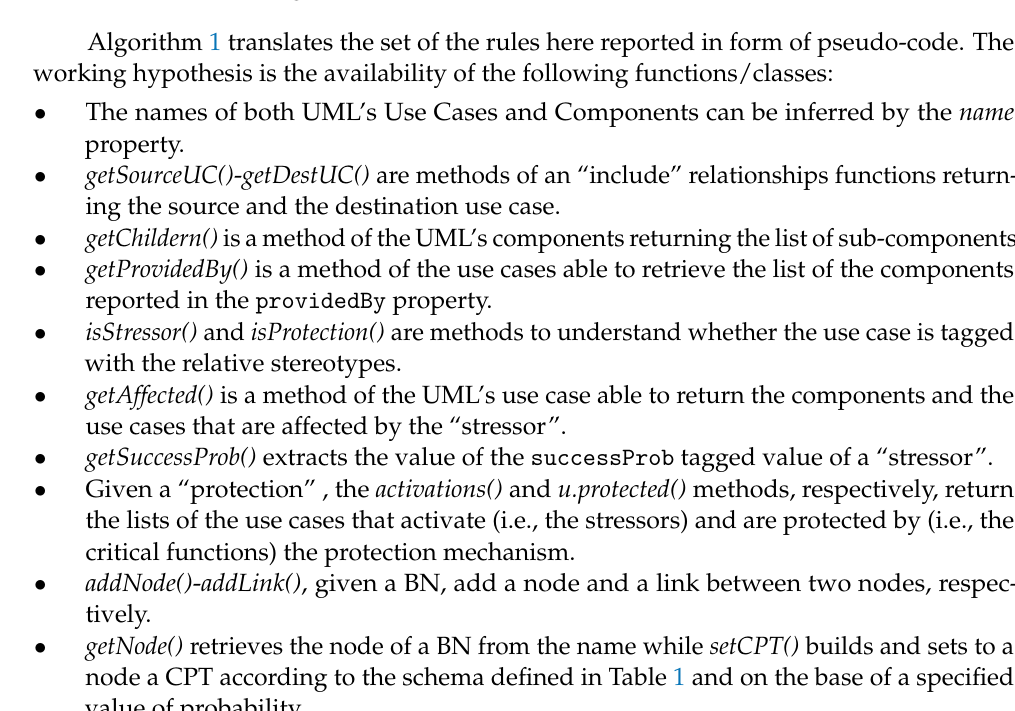
Figure 11. Generating BN model from CR UML